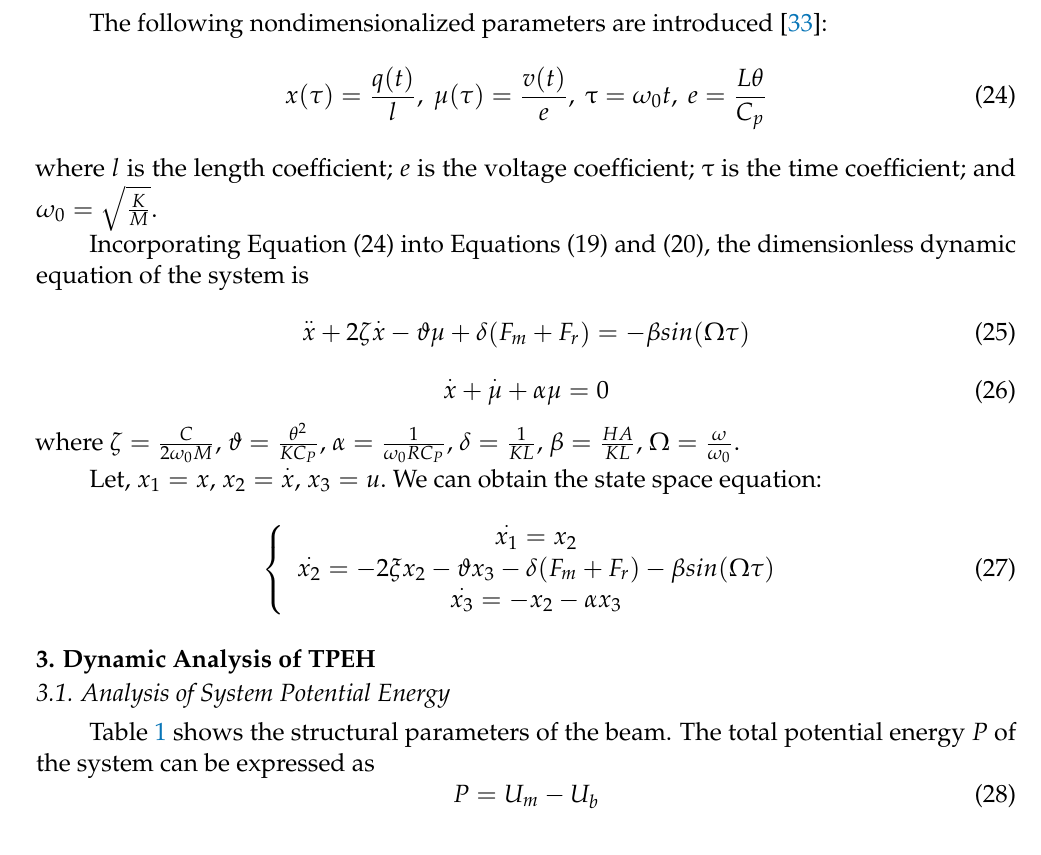
Table 1. Structure and material parameters of TPEH. Parameter Value Parameter Value linear-arch beam Piezoelectric